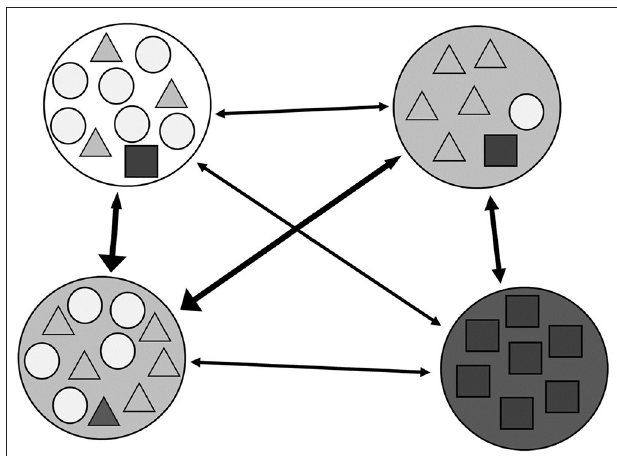
FIGURE 1 | Schematic representation of metacommunity dynamics. Circles indicate habitat patches (i.e., local communities) where increased shading represents increased local filtering on community composition. Shapes represent individuals of a species and congruent shading of species and patches represents a match between species and habitat. Arrows represent dispersal between local communities, with the thickness of the arrow shaft indicating overall dispersal rate between communities and size of the arrow head indicating possible asymmetry in